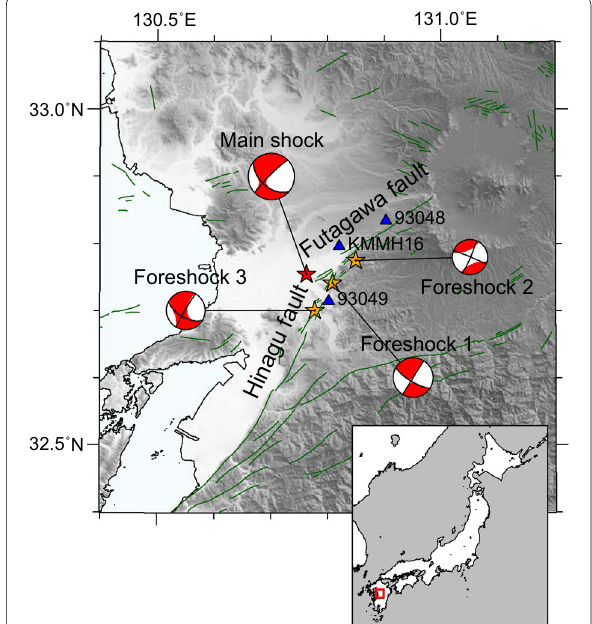
Fig. 1 Map of the studied area, indicated by red rectangle in the lower-right inset. Orange and red stars denote the locations of the epicenters of the three foreshocks and the main shock, respectively. MT solutions of the foreshocks and the main shock (National Research Institute for Earth Science and Disaster Resilience (NIED). http://www. fnet.bosai.go.jp/event/joho.php?LANG en. Accessed April 21, 2017) = are shown. Green lines represent surface traces of active faults